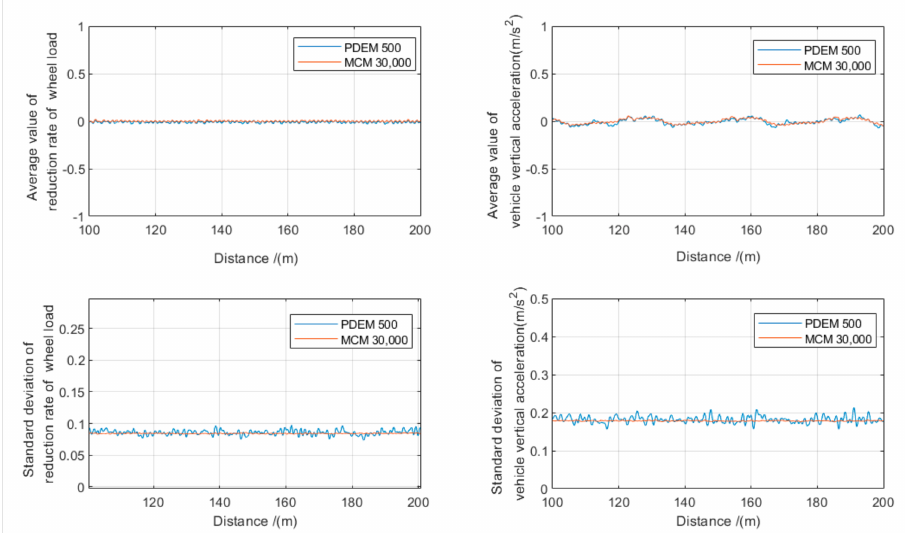
Figure 5. Comparison of indicator means and standard deviations.